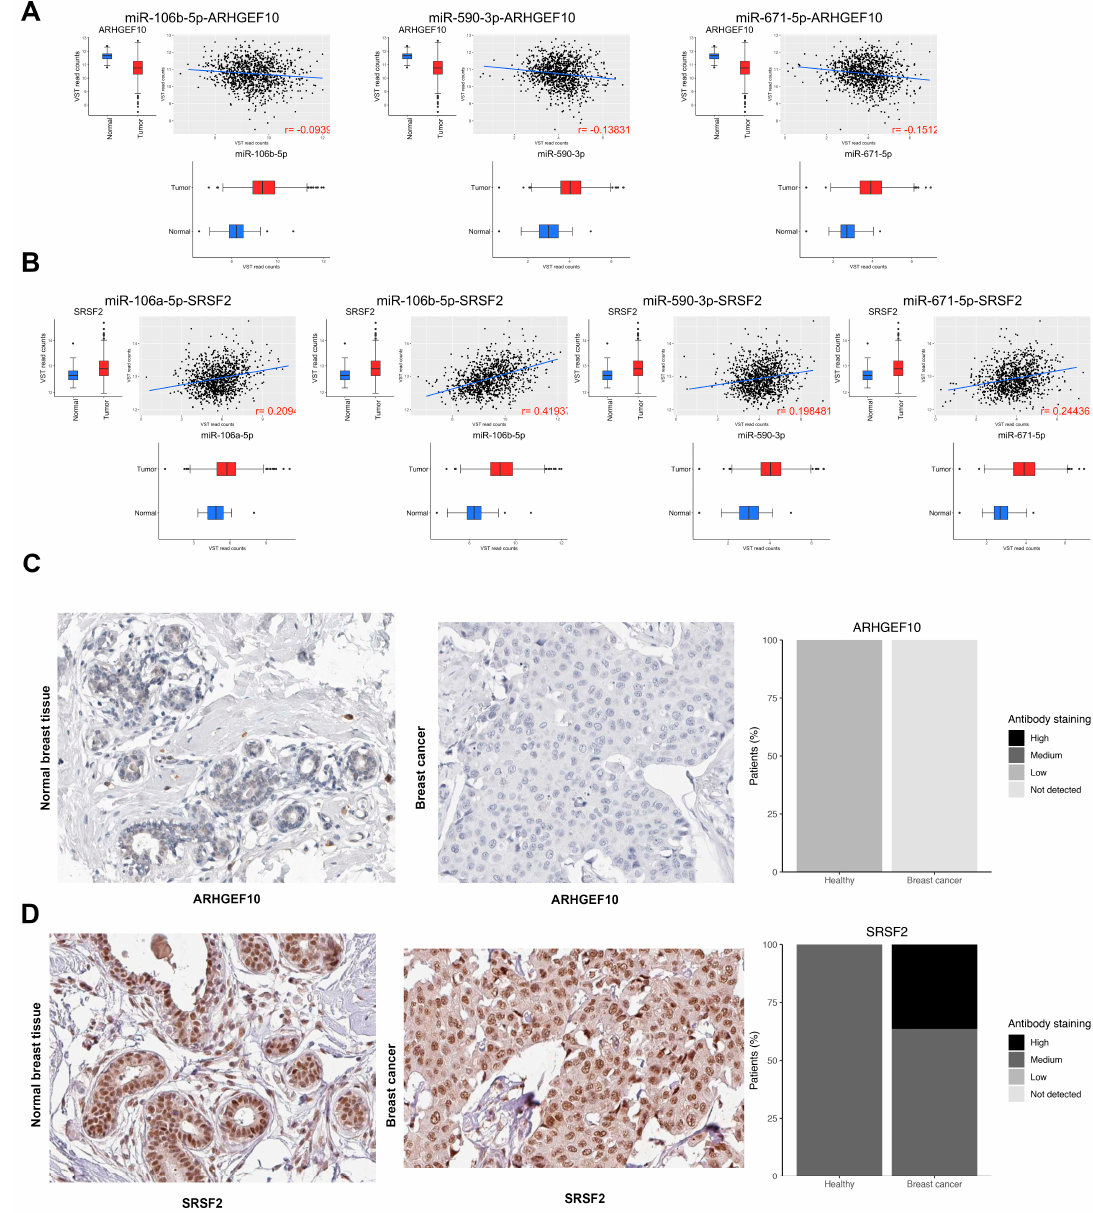
Figure 7. Correlation between the top OncoMMRs and the expression of the driver genes ARHGEF10 and SRSF2. ( A ) The correlation between the OncoMMRs and ARHGEF101. ( B ) The correlation between the OncoMMRs and SRSF2. Red boxplots represent the expression of the molecules in tumor tissues and blue in normal tissues. ( C , D ) protein expression of ARHGEF10 and SRSF2 from breast tissues of the human protein atlas.